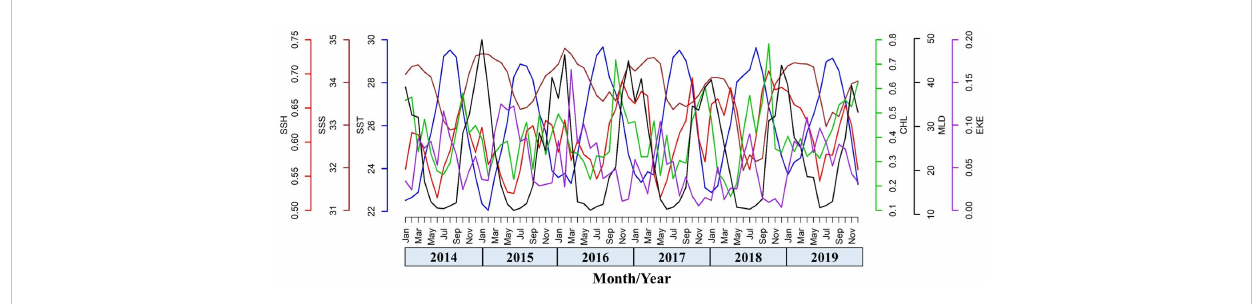
FIGURE 2 The monthly average time series trend of environmental factors from January 2014 to December 2019 in the Taiwan Strait.